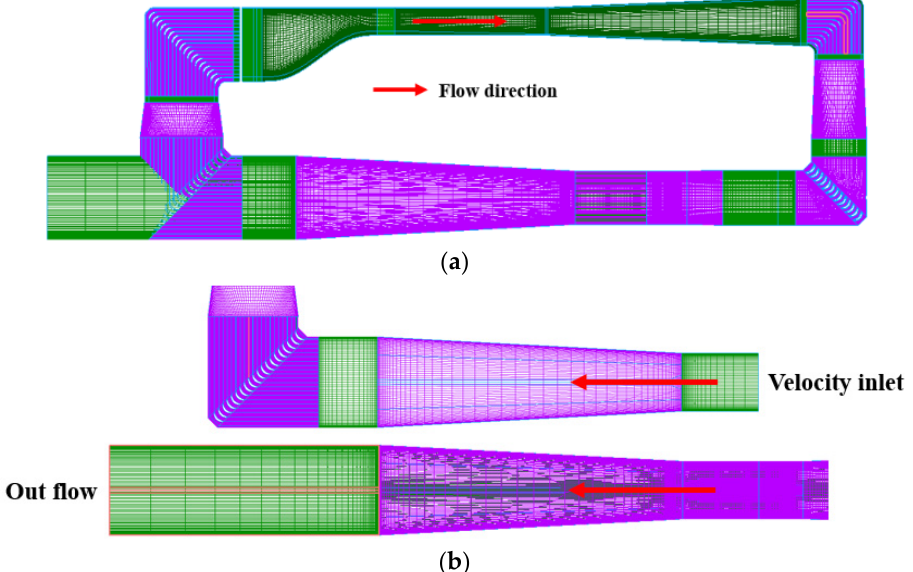
Figure 10. Grids system and boundary conditions of DSME large cavitation tunnel. ( a ) Overall domain. ( b ) Boundary conditions.